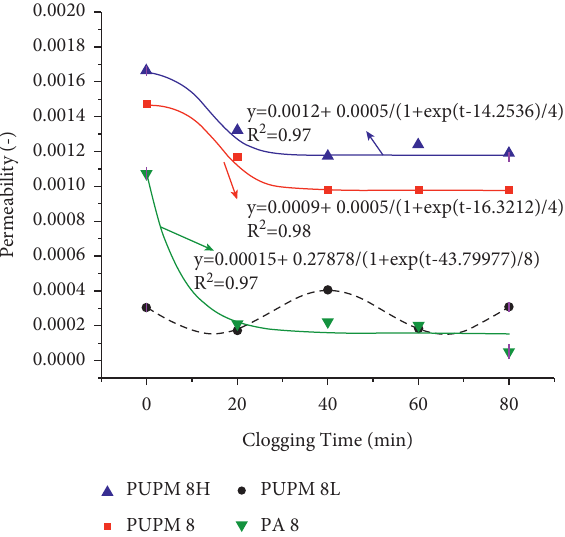
Figure 6: Plot of permeability coefficients for PUPM specimens and PA specimen at the hydraulic head of 300mm during the clogging development [19].